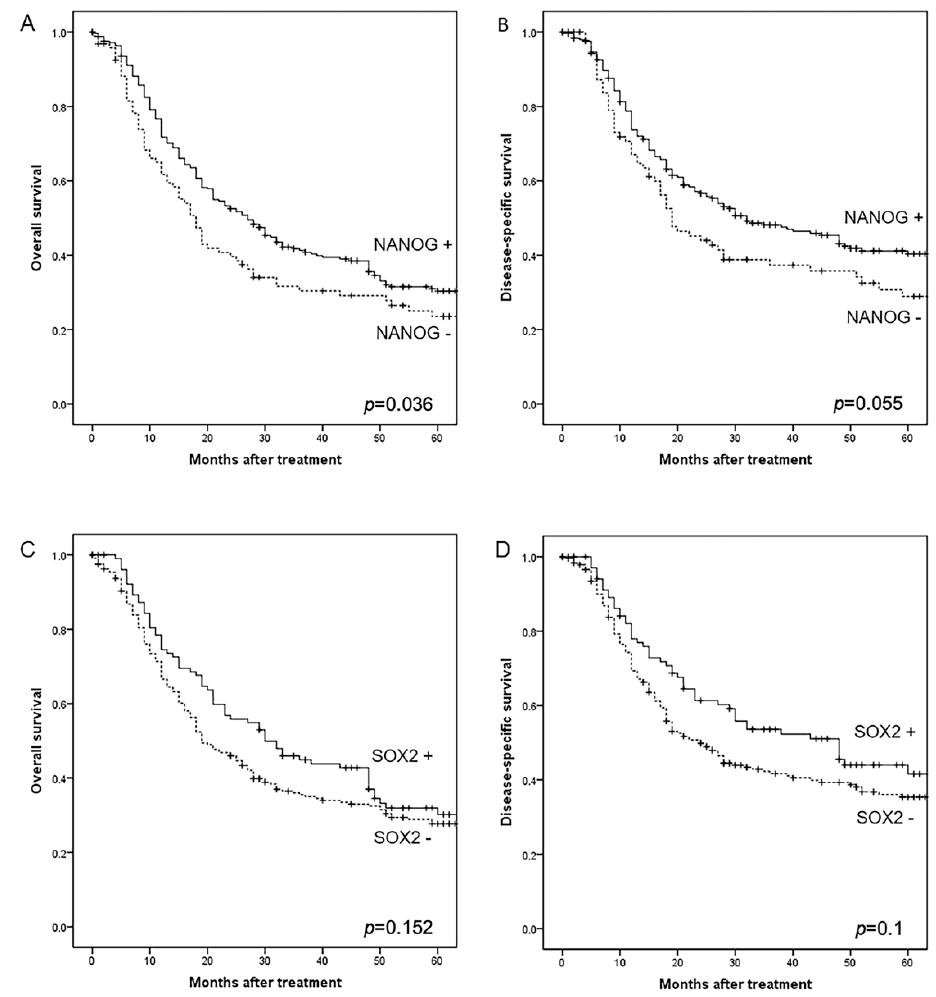
Figure 2. Kaplan–Meier overall and disease-specific survival curves in the whole series categorized by NANOG ( A , B ) and SOX2 expression ( C , D ).